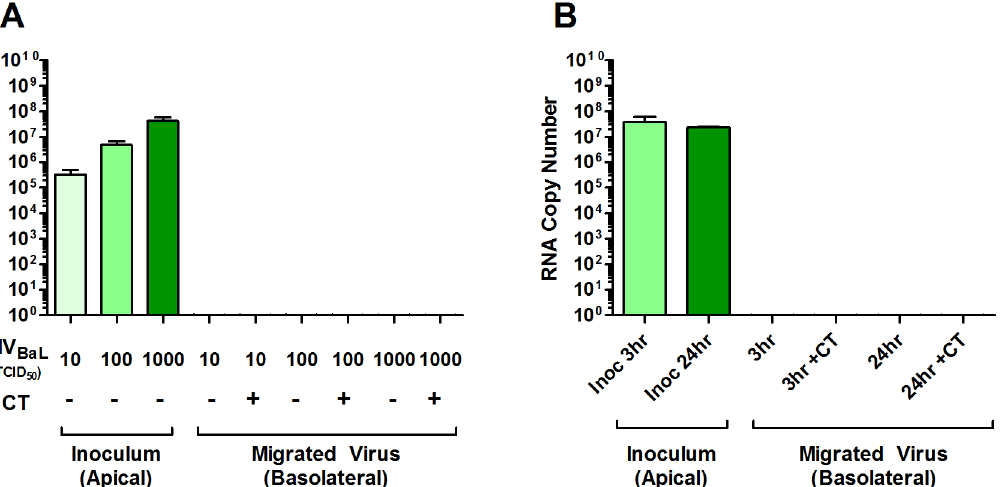
Fig 1. Cell-free HIV does not migrate across mock or CT-infected A2EN cells. ( A ) A2EN cells were infected with CT serovar D ( > 95% infection rate) for 71 h as described in Materials and Methods. 10, 100, or 1000 TCID 50 of cell-free HIV BaL was added to the apical chambers of mock and CT-infected A2EN cells for 1 h at either 4°C or 37°C so that the CT infection duration was 72 h total. ( B ) 1000 TCID 50 of cell-free HIV BaL was added to the apical chambers of mock and CT-infected A2EN cells for 3 or 24 h at 37°C for a total CT infection duration of 72 h. Basolateral supernatants were then collected and analyzed for viral RNA using quantitative real-time PCR. Bars represent the mean values of RNA copies ± the standard deviation (SD). Data is representative of 4 independent experiments, each performed in quadruplicate. * p < 0.05.